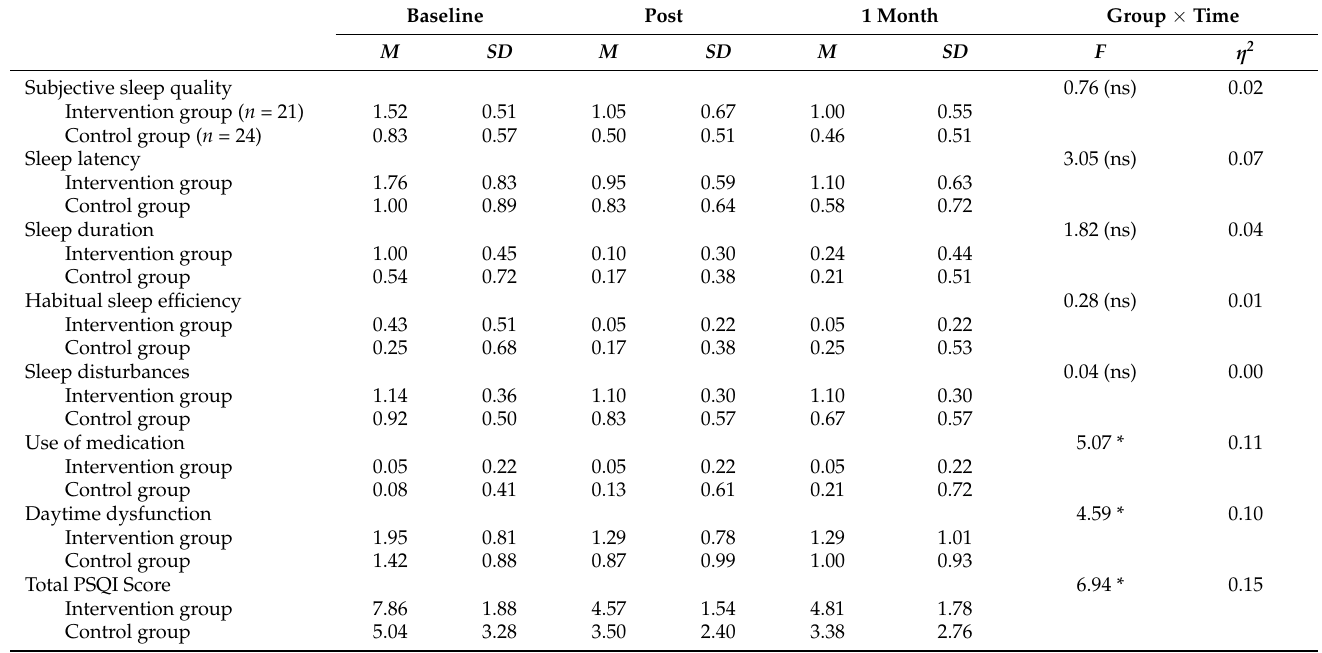
Table 3. Descriptive and inferential statistics for sleep related outcomes.